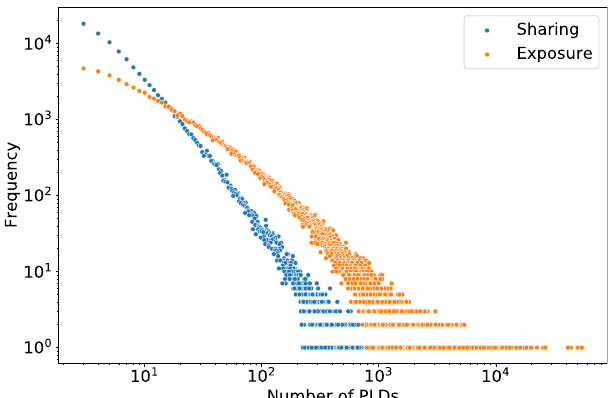
Figure 7. Distribution of number of PLDs users generate (shown in blue) and are exposed to (shown in